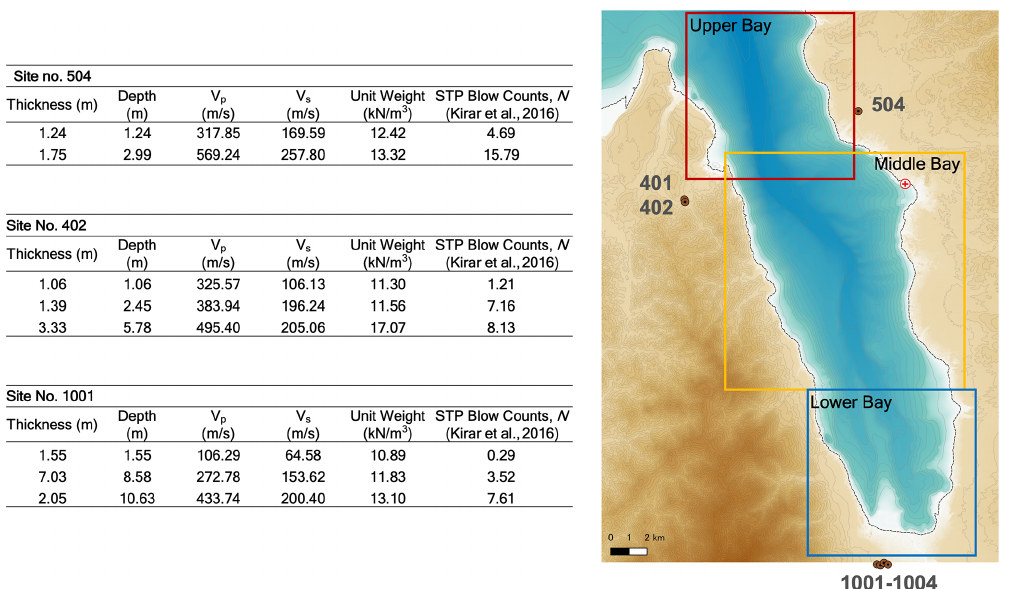
Figure 4. Soil condition data for observation site nos. 1001, 402, and 504 and the Palu Bay zones delineated by the soil properties. The table includes the shear-wave velocity profile P ( V p ) and S ( V s ) parameters inferred from HVSR microtremor inversion, as well as the soil density over the soil depth and the soil thickness in each